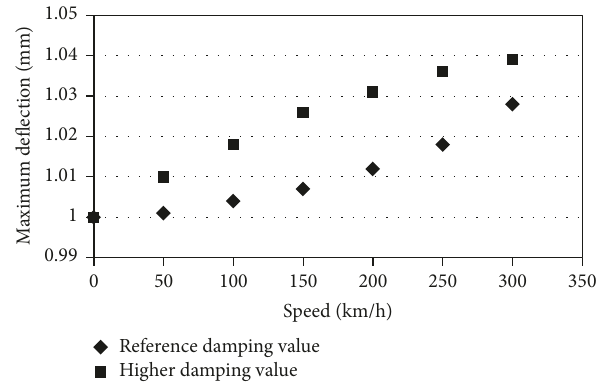
Figure 1: Dynamic factor for the Euler-Bernoulli beam and various damping properties of rail foundation.